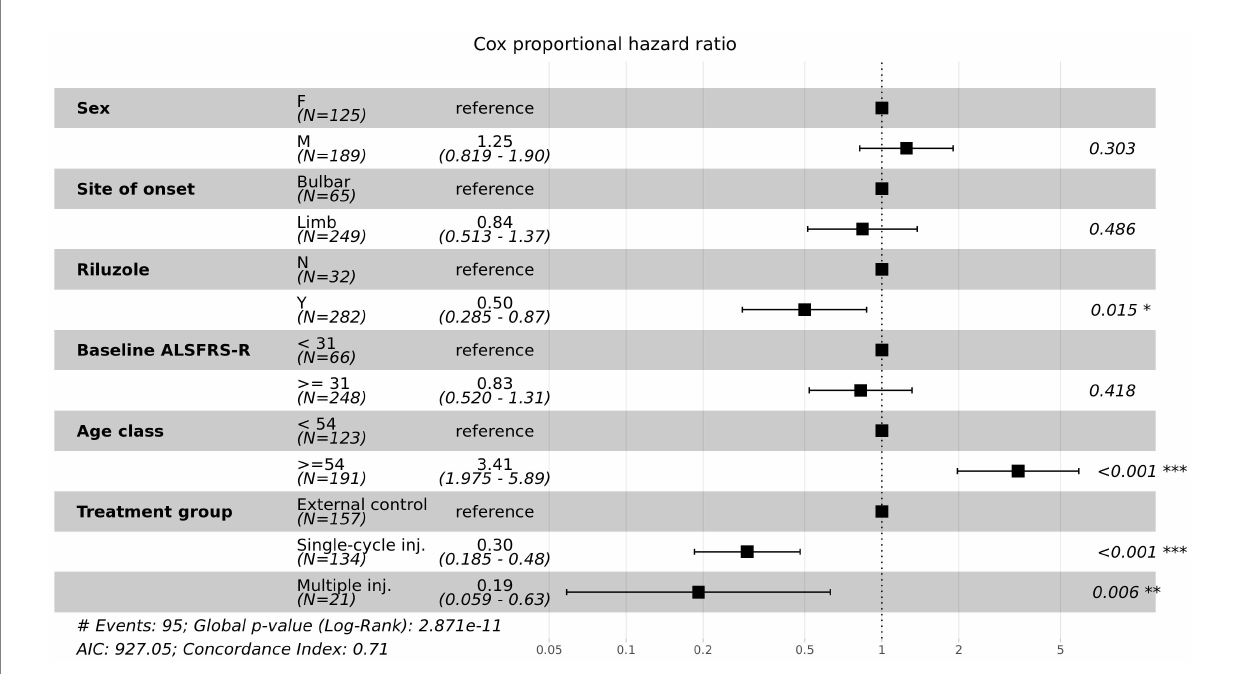
FIGURE 4 Forest plot for multivariate Cox proportional hazards model. Hazard ratios (HRs) and 95% confidence intervals (CIs) were calculated for the risk factors associated with time to